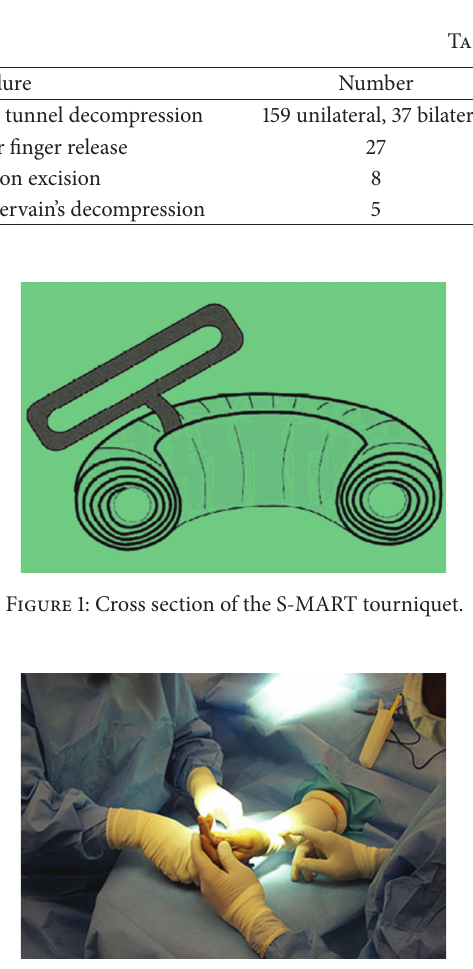
Figure 2: S-MART after